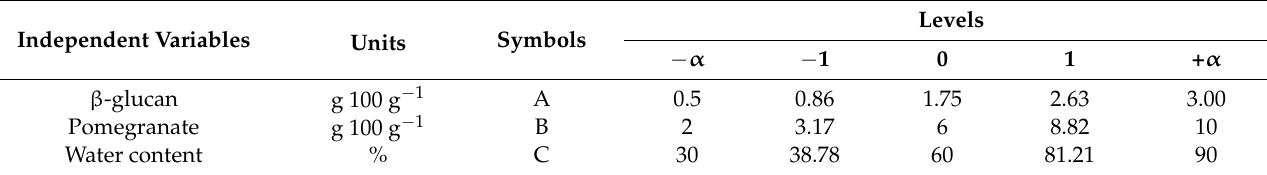
Table 1. Levels of different variables in coded form for muffin